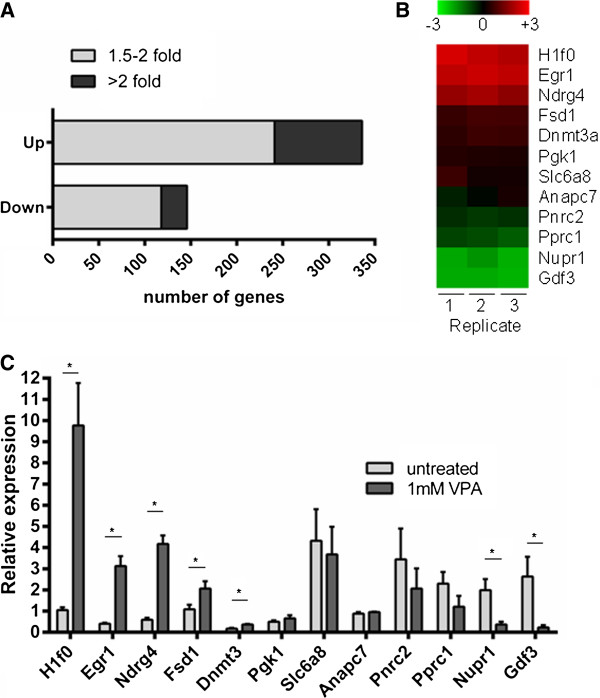
Valproic acid treatment changes expression of only a small proportion of genes in embryonic stem cells. Embryonic stem (ES) cells (CCE/R) were treated for 8 h with 1 mM valproic acid (VPA) and the NIA15K cDNA microarray was used to compare gene expression in control and treated cells. The use of three biological replicates allowed statistical testing (t-tests) to classify genes by the level of significance (P-value) of their expression change. (A) Genes for which the change in transcript level (up or down) had a P-value after FDR correction, equal to or less than 0.1, and a mean change of at least 1.5-fold, were classed as up- or down-regulated, as indicated. The histogram shows the numbers of genes where the significant fold change is 1.5- to 2.0-fold (light grey) or >2.0-fold (dark grey). (B) Heat map showing gene expression change in three replicate experiments along with a list of representative genes showing different levels of change. (C) To validate microarray results, representative transcripts were quantified by real time-quantitative (RT-q)PCR in untreated and VPA-treated cells. Error bars represent the standard error of the mean of independent experiments (n = 3). To assess significance of a change, two-tailed unpaired t-tests were performed using the GraphPad software; *P <0.05.